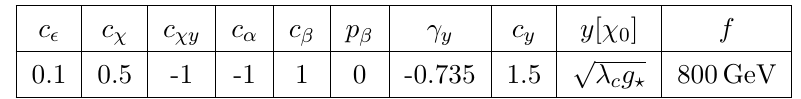
Table 2 . De(cid:12)nition of our benchmark point. Here y refers to the one charm mixing (either for the left- or right-handed chirality) that is chosen to vary and (cid:21) c is the charm Yukawa.